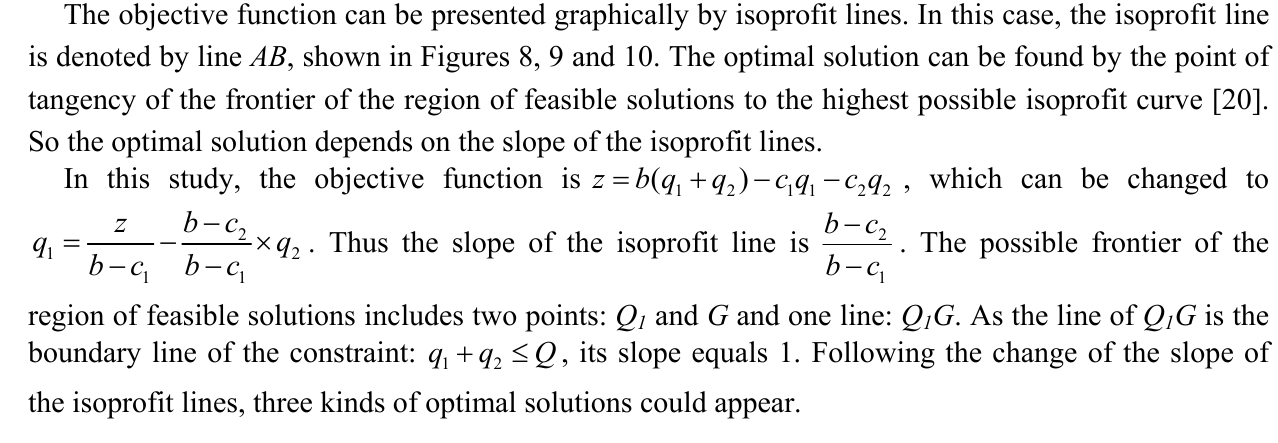
Figure 8. Optimal solution 1 (the isoprofit slope <1).